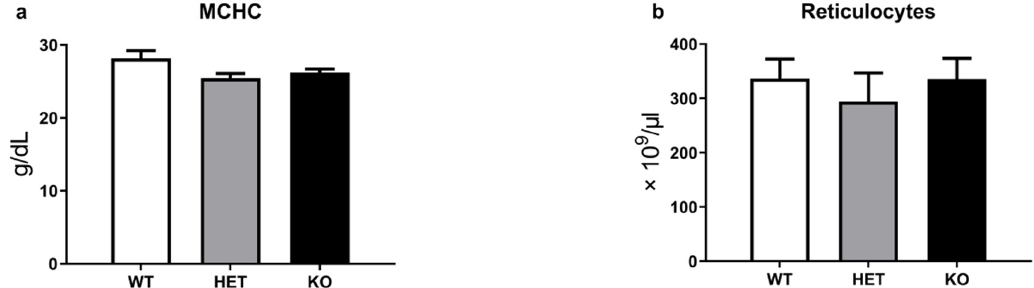
Figure 2. Erythropoiesis parameters of WT, HET, and TAAR5-KO (KO) mice. There are no significant changes in MCHC ( a ) and reticulocytes parameters ( b ). Data are mean ± Standard Error of the Mean (SEM).